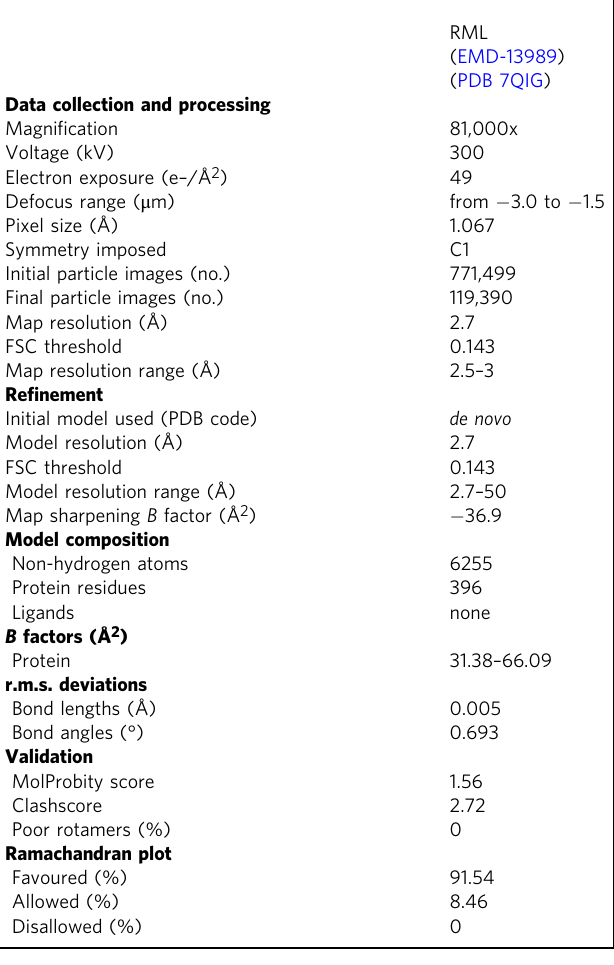
Table 1 Cryo-EM data collection, re fi nement and validation